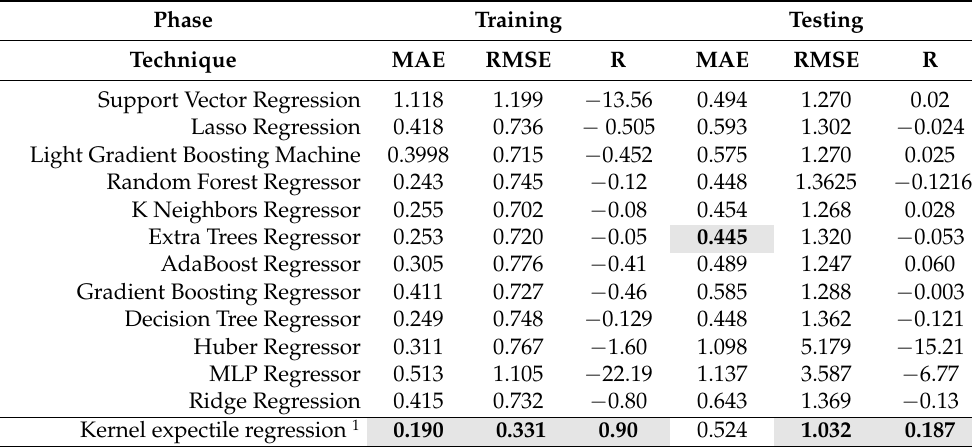
Kernel expectile regression 1